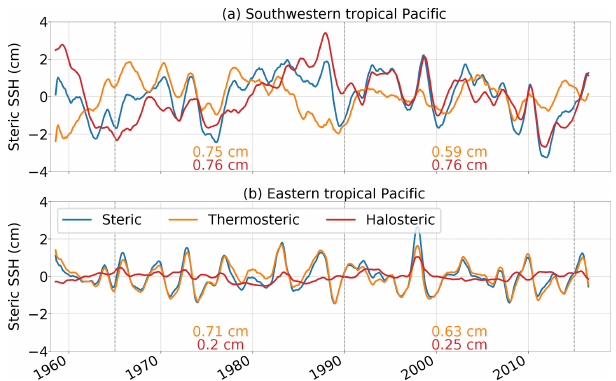
Figure 5. Time series of steric SSH anomalies from O025-HC, O025-W90 and O025-B90 averaged over boxes in the (a) south- western and (b) eastern tropical Pacific. Exact regions are shown as red boxes (1, 2) in Fig. 4. Thick lines are smoothed with a 12- month running mean. Thin lines are low-pass filtered with an 8-year Butterworth filter. Dashed line in panel (b) indicates Niño3.4 index.